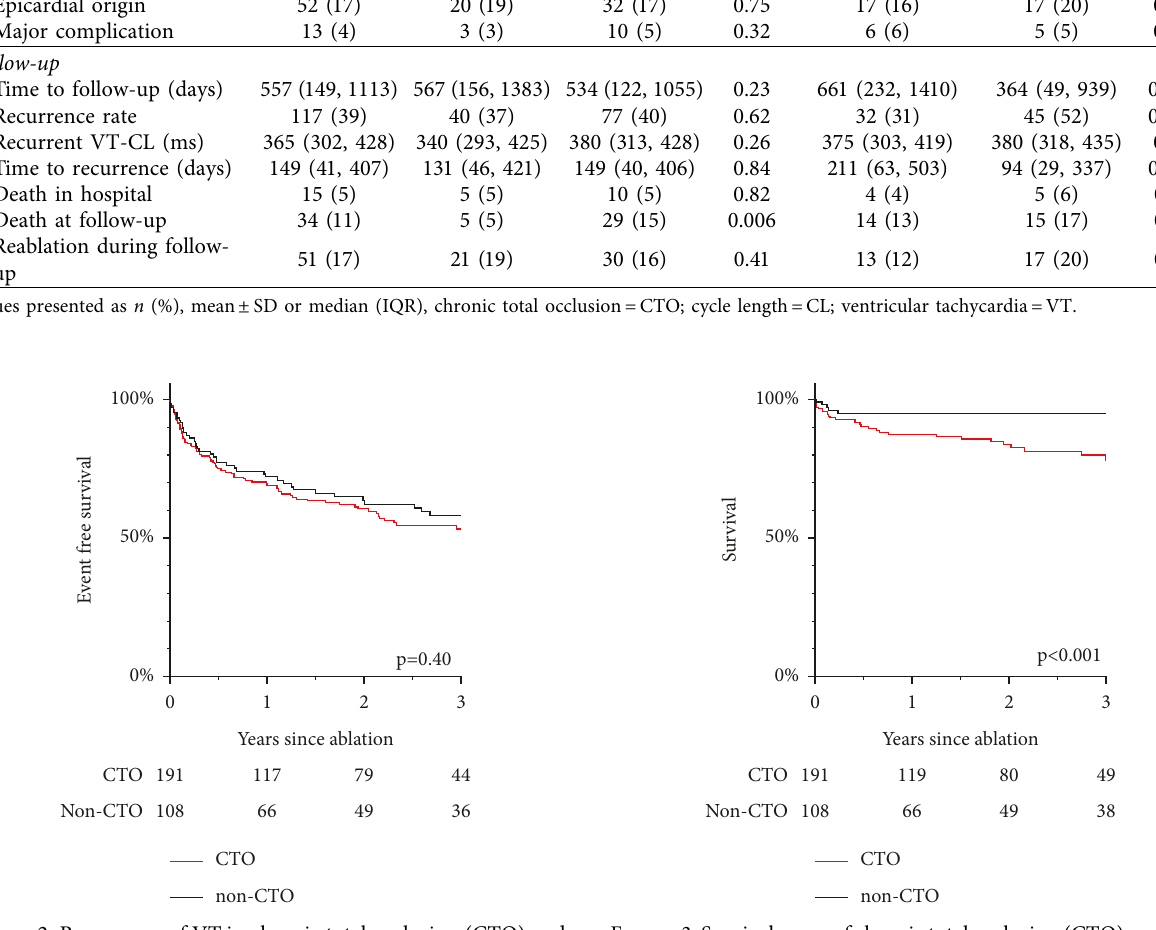
Figure 3: Survival curve of chronic total occlusion (CTO) and non- CTO